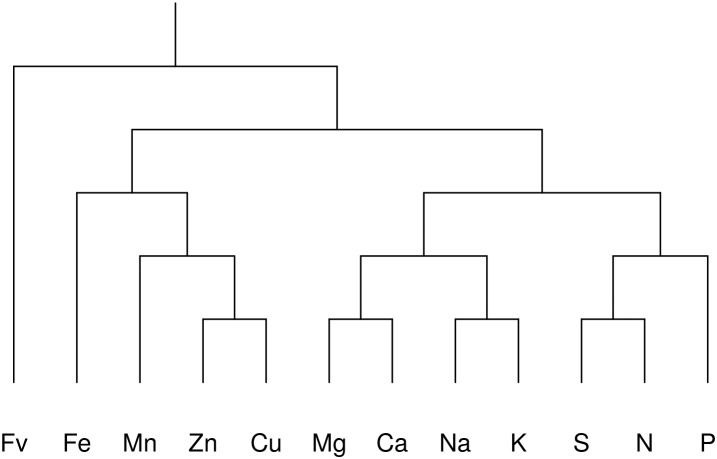
Bifurcating tree identification showing 11 hierarchical balances representing a subcomposition of nutrients in the lettuce ionome: [Fv | Fe,Mn,Zn,Cu,Mg,Ca,Na,K,S,N,P], [Fe, Mn,Zn,Cu | Mg,Ca,Na,K,S,N,P], [Fe | Mn,Zn,Cu], [Na,Mg,K,Ca | N,S,P], [Mn | Zn,Cu], [Mg,Ca | Na,K], [S,N | P], [Zn | Cu], [Mg | Ca], [Na | K], [S | N]. The experimental effect on nutrient balances was removed prior to data processing using mixed modeling with the nutrient balance as response and the experiment as random intercept (more details in the Results section).